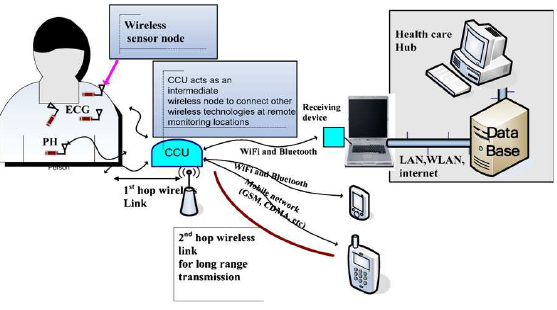
Figure 4: A typical model of WBAN